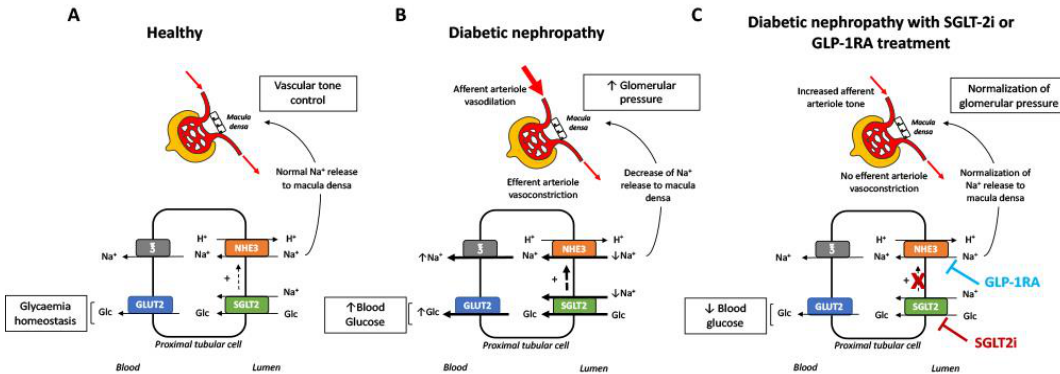
Figure 1. Mechanisms of glucose reabsorption and intraglomerular pressure control in healthy individuals and in diabetic patients. ( A ) In healthy individuals, approximately 90% of glucose is reabsorbed by SGLT2 that is located at the apical membrane of the proximal tubular cells and transported back to the blood stream by the basolateral glucose transporter 2 (GLUT2) transporter. Na + is reabsorbed by the apical transporters SGLT2 (with glucose) and the Na + /H + exchanger isoform 3 (NHE3) and returned to the circulation via several basolateral Na + transporters: sodium bicarbonate transporters, Na + channels, and the Na + /K + ATPase. Tubular glucose and Na + reabsorption mechanisms contribute to glucose homeostasis and glomerular tone control thanks to the tubuloglomerular feedback controlled by the macula densa. ( B ) In diabetic patients, glucose and Na + reabsorption mechanisms are increased secondary to the hyperfiltration. This fact contributes importantly to the hyperglycaemia and raises the intraglomerular pressure. ( C ) Both SGLT2i and GLP-1RAs produce natriuresis that leads to a decrease of the glomerular pressure. In the case of SGLT2 inhibitors, the natriuretic effect is due to the direct blockade of SGLT2 and the collateral inhibition of NHE3, which has an SGLT2 dependent activity. Regarding GLP-1RAs, these drugs impair only NHE3 activity by an unknown mechanism. Moreover, SGLT2 inhibition contributes to blood glucose level control. ℥ :